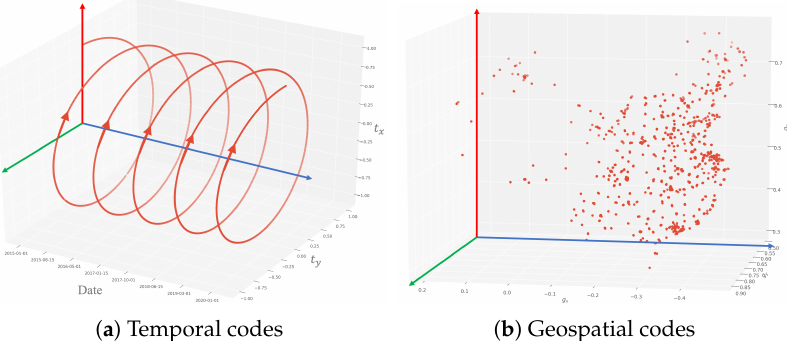
Figure 3. Illustration of the ( a ) temporal codes (TC) and ( b ) geospatial codes (GC), which will be input as variables to the GTJC